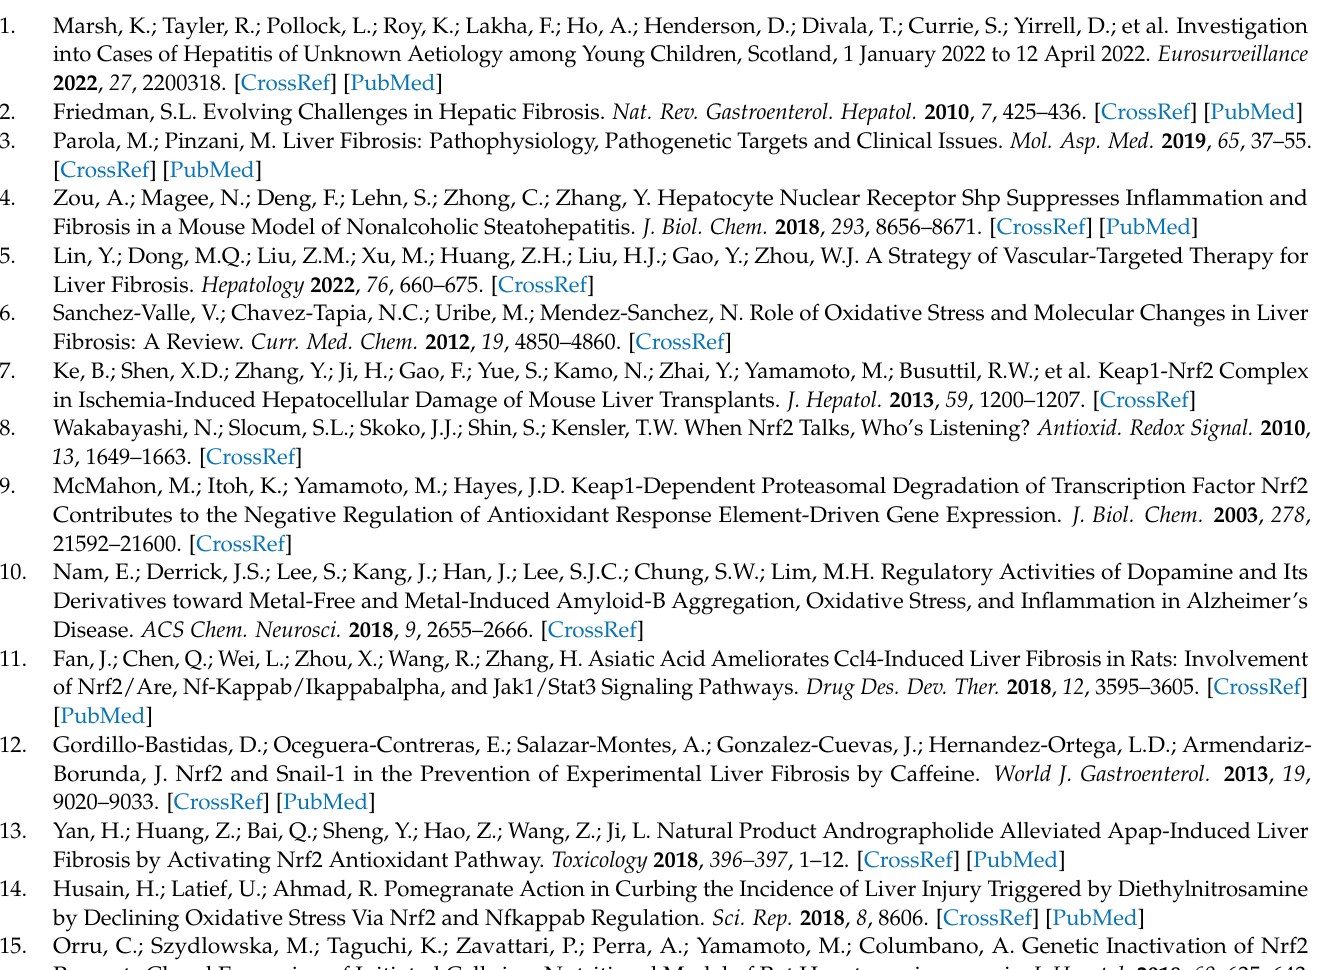
Table S2: Ishak scoring system for liver inflammation, Table S3: The antibodies used for western blotting, and Table S4: Primers for